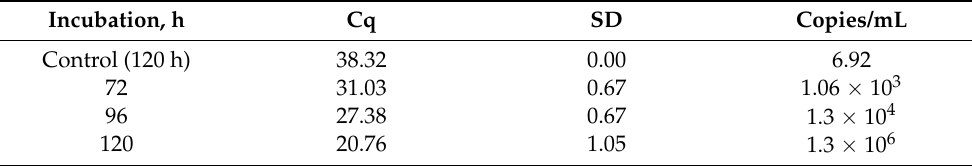
Table 3. Results of qPCR carried out on material obtained from artificially infected potatoes. APC permease gene of Ppa was detected using developed primers. SD is standard deviation.